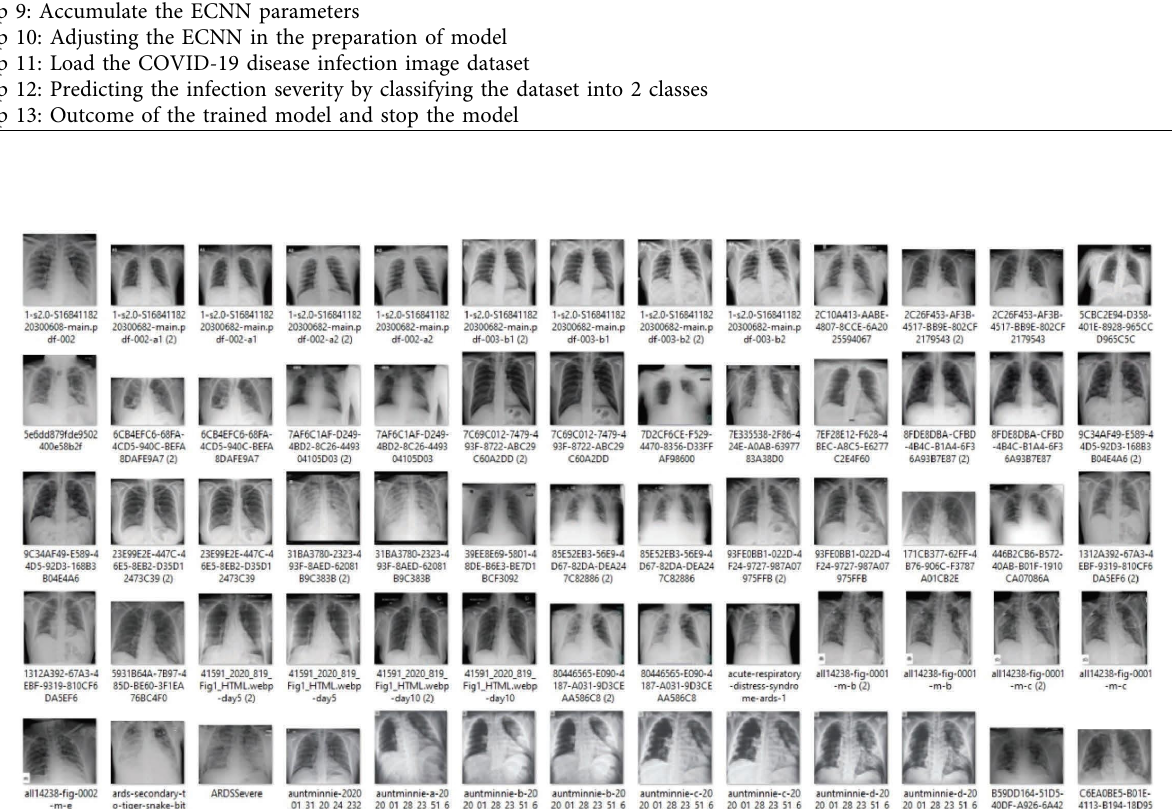
Figure 4: Sample input dataset of the projected prototype for COVID-19 disease